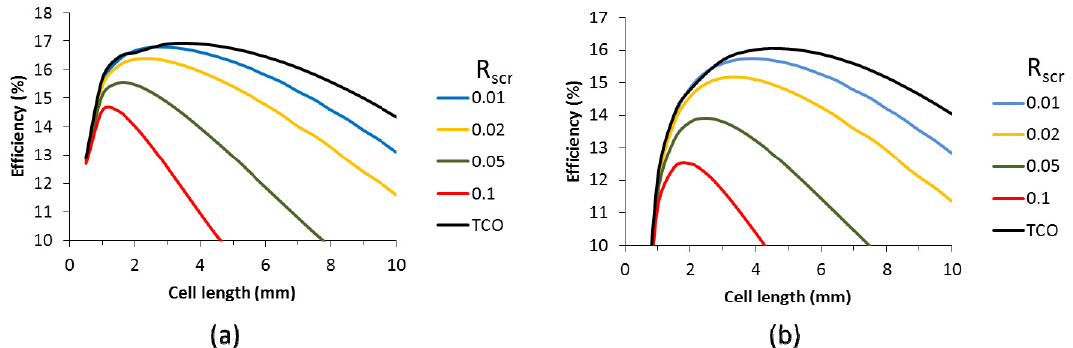
Figure 10. Efficiency as a function of the cell length and specific contact resistance for cells with 150 μ m ( a ) and 350 μ m ( b ) scribe width.